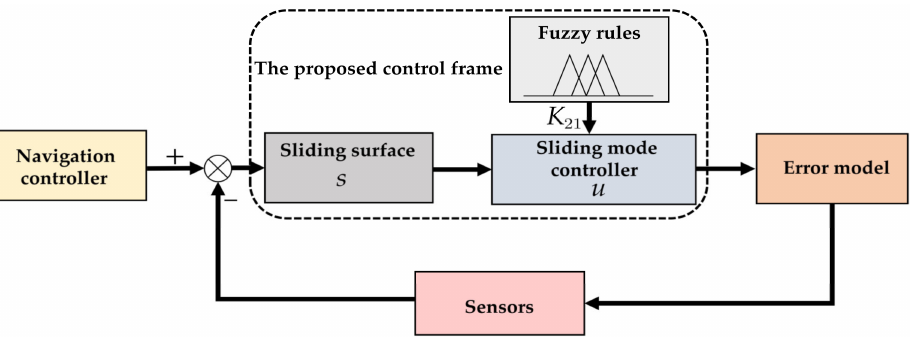
Figure 2. Schematic of the proposed path tracking